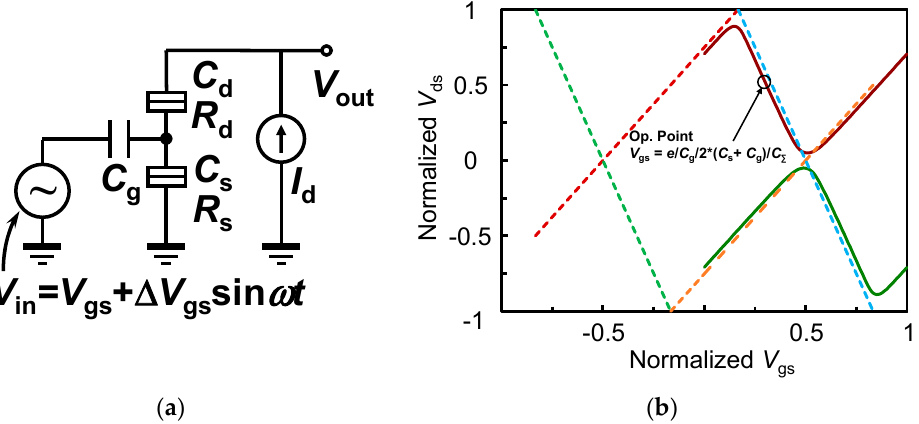
Figure 7. ( a ) A circuit diagram of the SET-based inverting amplifier with constant-current load, and ( b ) Coulomb diamond (CD) plot with V ds - V gs curves for I d = ±26.7 pA at T = 15.5 K [0.05]. The operation point of the amplifier is set at the center of the descending side.